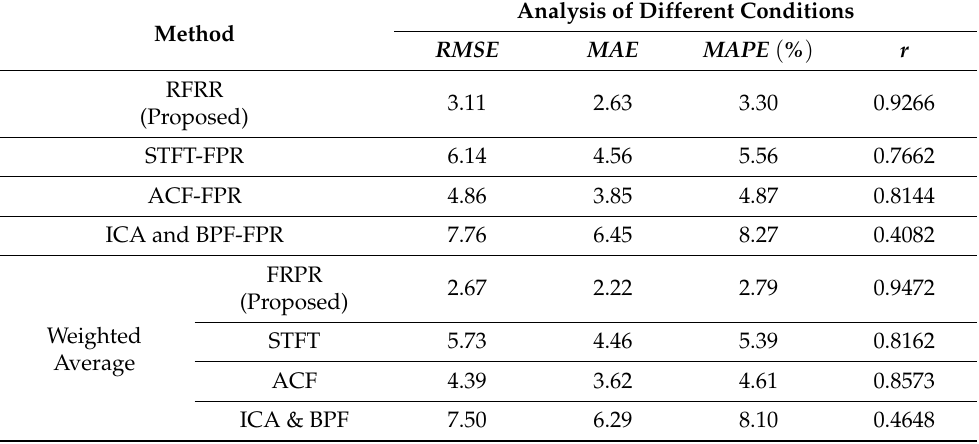
Table 2. Comparative results of the FPR on indoor dataset.